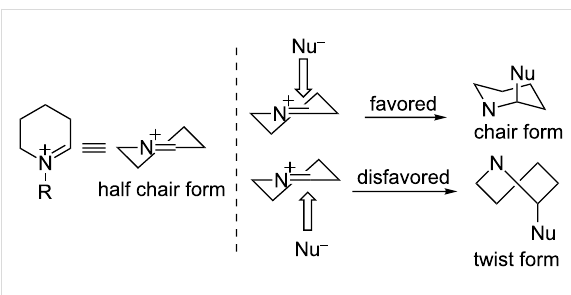
Figure 5: Stevens’ hypothesis on the tendency of the addition of nucleophiles to N -acyliminium ions. The substituent at the nitrogen atom is omitted for